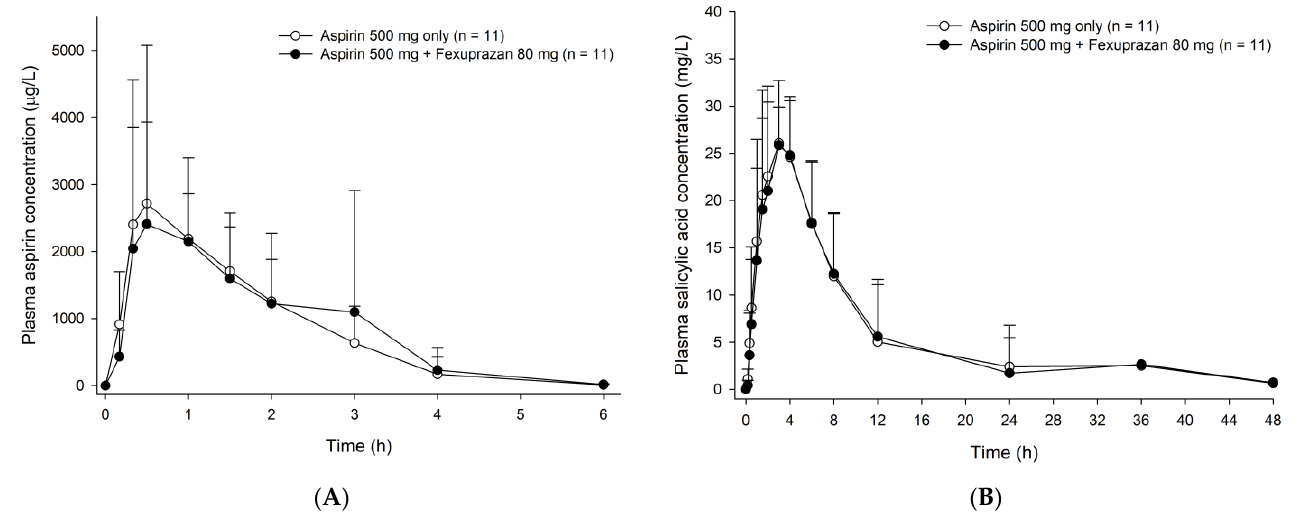
Figure 3. Mean plasma concentration-time profiles of ( A ) aspirin and ( B ) salicylic acid measured after a single oral administration of aspirin 500 mg alone and coadministered with fexuprazan 80 mg. The error bars represent the standard deviations. Table 1. Pharmacokinetic parameters of aspirin determined after a single oral administration of aspirin 500 mg alone and coadministered with fexuprazan 80 mg.